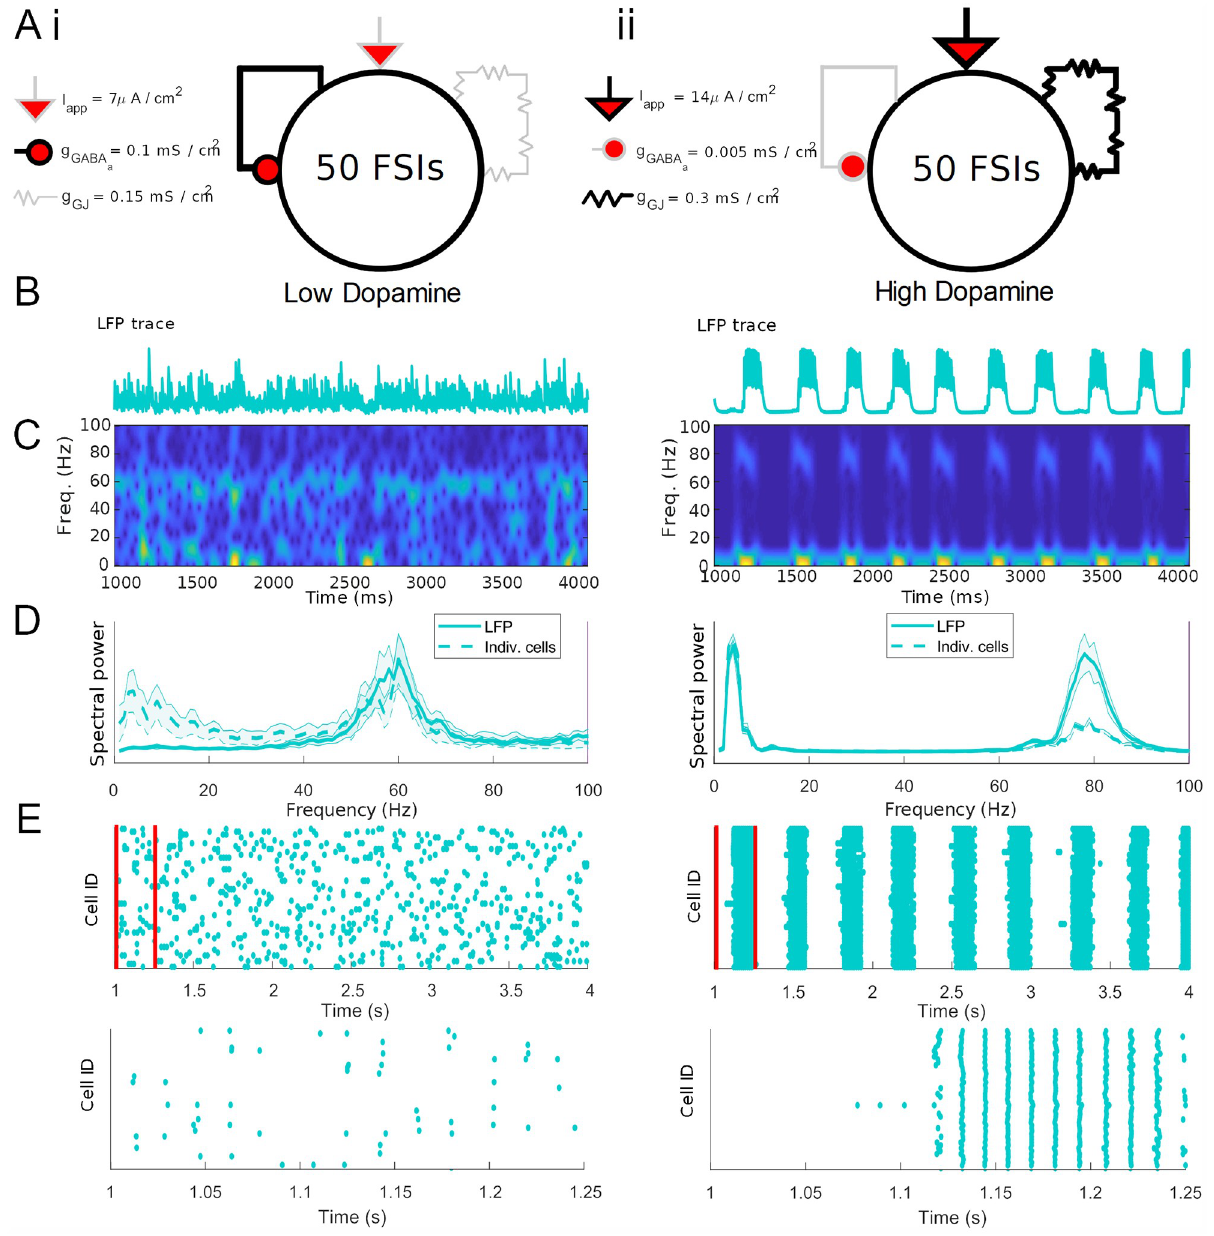
Fig 4. FSI network activity and rhythms are altered by DA. (A) Schematics showing the effects of dopamine on the FSI network during the baseline (i) and high (ii) DAergic tone conditions. (B) Sum of synaptic currents (surrogate LFP) for the FSI network in the two conditions. (C) Spectrograms of (B). (D) Solid line: Power spectral density of summed FSI synaptic currents (surrogate LFP), averaged over 20 simulations. Dashed line: Average power spectral density of each individual FSI voltage trace in the network, averaged over 20 simulations. Shading represents standard deviation from the mean. (E) Raster plots of FSI network activity at multisecond and subsecond timescales (red bars indicate time limits of lower raster plot).